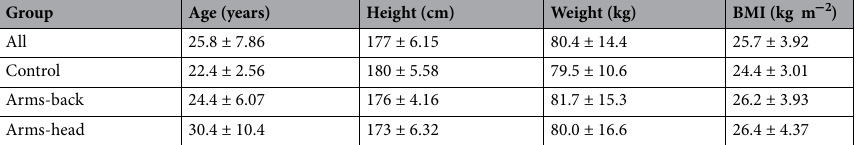
Table 2. Demographics for the full subject pool and for each restraint posture are shown as means ± standard deviations. BMI: body mass index.